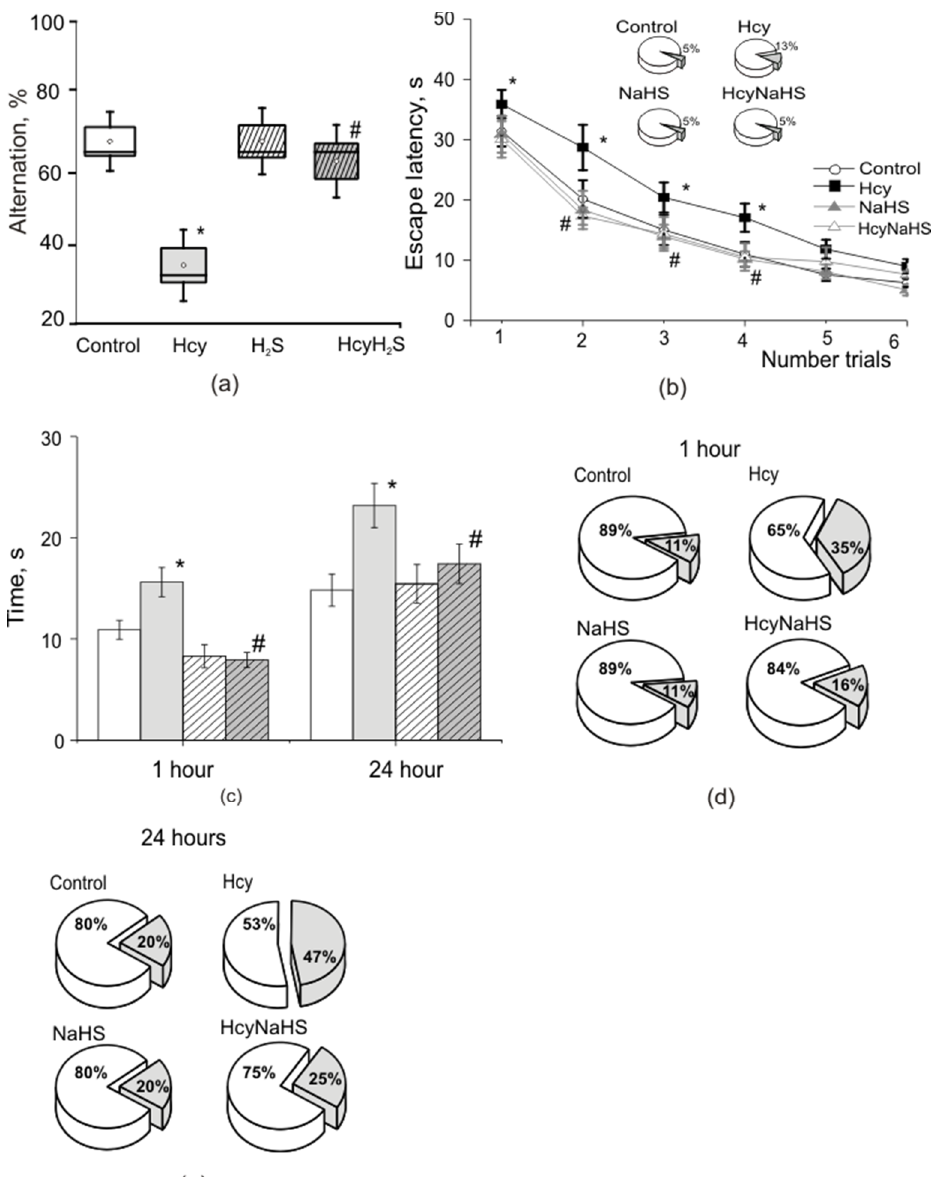
Figure 6. Effects of maternal hHcy and NaHS treatment on cognitive functions in T maze and Morris test. ( a ) Percentage of alternation in the T maze of rats from control (white box); Hcy (grey box), NaHS (dashed box), HcyNaHS (grey dashed box) groups. ( b ) Escape time during learning in the Morris maze of rats in control (white circles), Hcy (grey circles), NaHS (white square), HcyNaHS (grey square) groups. The insert indicates the percentage of rats able of learning (white sector) and failures (grey sector). ( с ) Time necessary to find the target quadrant in 1 h and 24 h after the training of rats from control (white columns), Hcy (grey columns), NaHS (dashed columns), HcyNaHS (grey dashed columns) groups. Ratio of animals able to remind the platform location (white sectors of the circles) and failures (grey sector) after 1 h ( d ) and 24 h ( e ). * p < 0.05 compared to the control group, # p < 0.05 compared to the Hcy group.